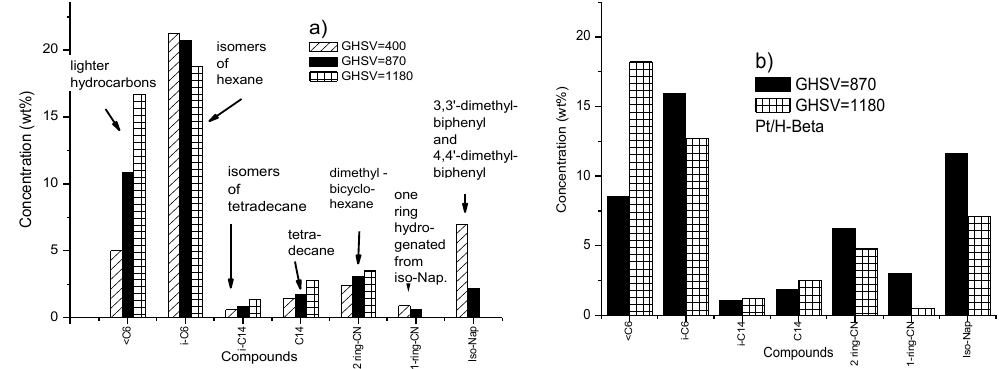
Figure 6. Product distribution for hydro-isomerisation of Toluene, P = 5.0 MPa, T = 240 °C& LHSV = 1 h –1 for different GHSV (mln/(g.cat).h) (based on test method ASTM D2887) (<C 6 : lighter hydrocarbons, i-C6:isomers of hexane (iso-hexane), i-C 14 :isomers of tetradecane, C 14 : tetradecane, Iso-Nap: 2,2′-dimethyl biphenyl, 3,3′-dimethyl biphenyl and 4,4′-dimethyl biphenyl, 2-ring-CN: two ring hydrogenated from iso-Nap (dimethyl bicyclohexane), 1-ring-CN: one ring hydrogenated from iso-Nap.) ( a ) Hydro-isomerisation of Toluene using Pt-Cl/ H -β ( b ) Hydro-isomerisation of Toluene using Pt/ H -β.